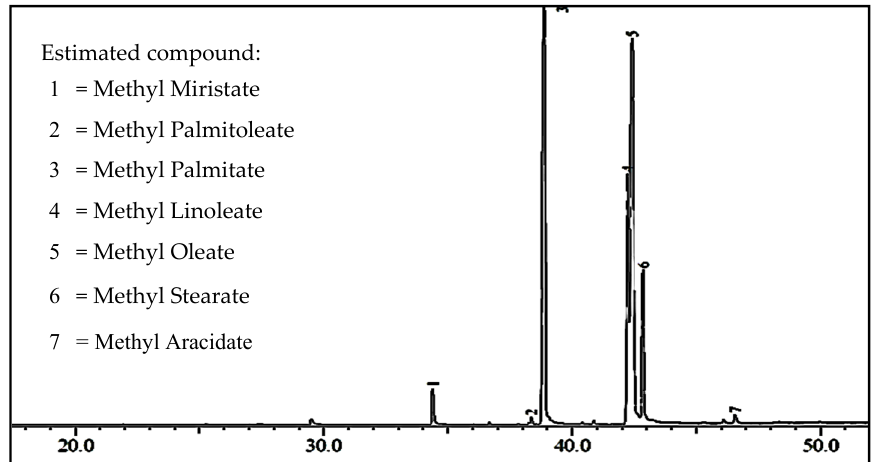
Figure 5. The chromatogram of transesterification products resulted from palm oil off-grade using Figure catalyst.